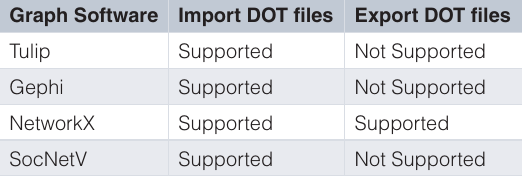
Table 1. Some graph visualization and analysis software and their compatibility with DOT